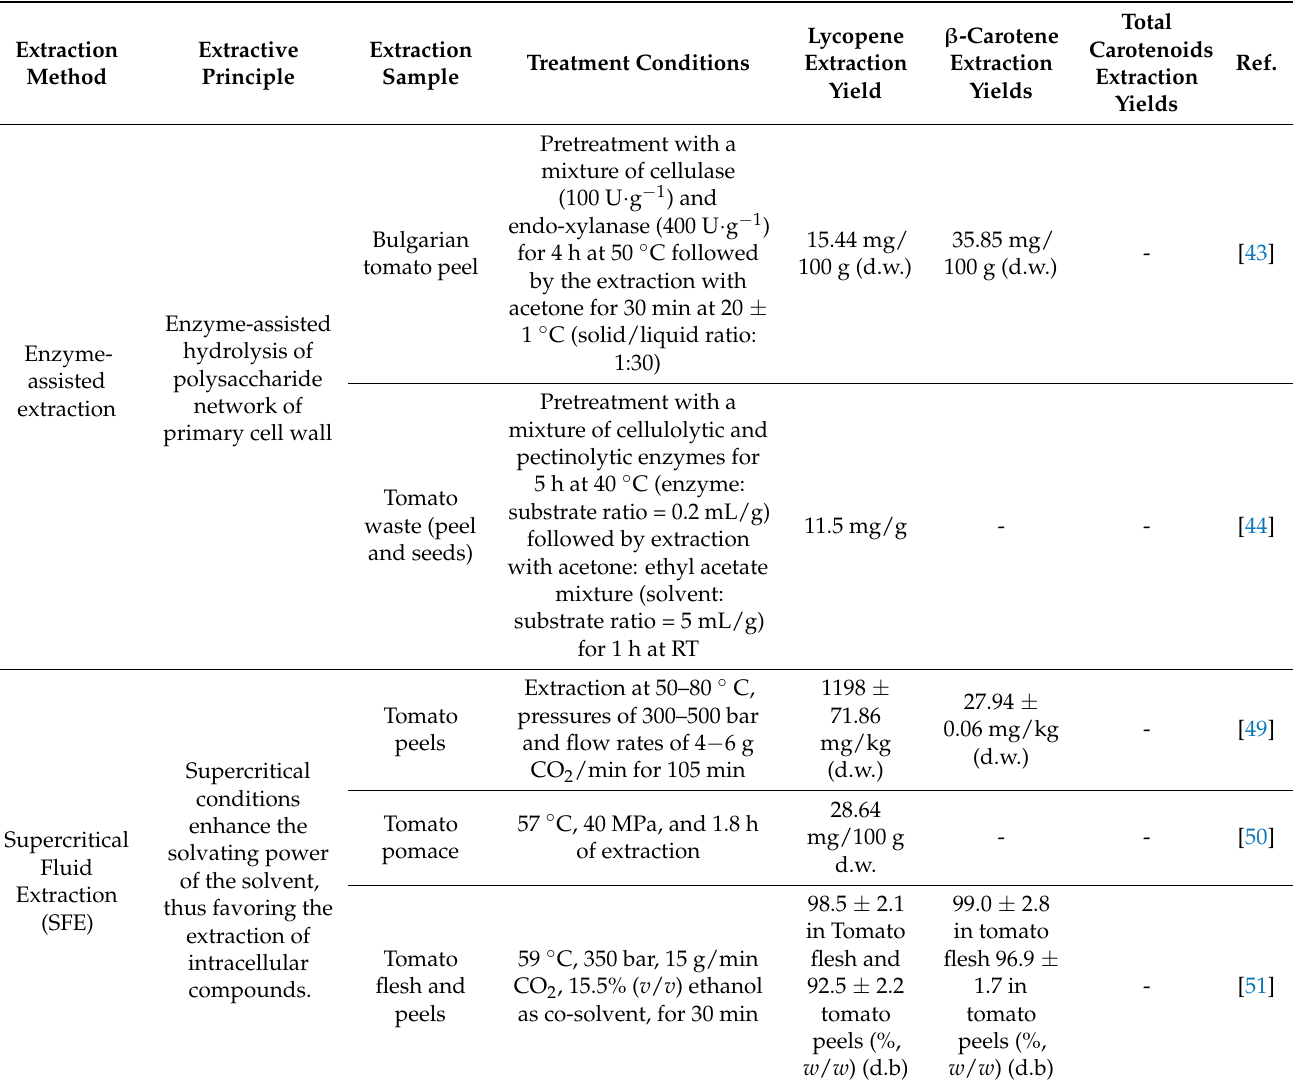
Table 1. Latest and innovative extraction